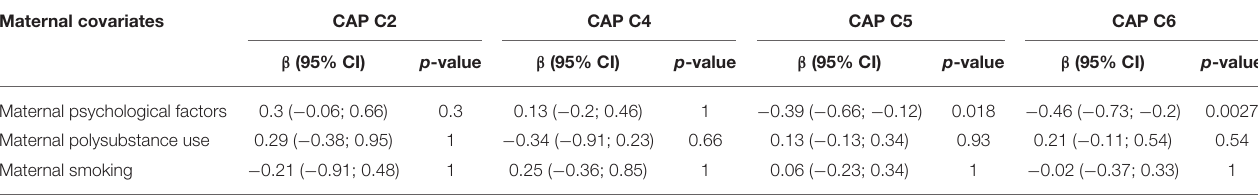
TABLE 3 | Association estimates of the maternal risk factors and CAP network components. Maternal covariates